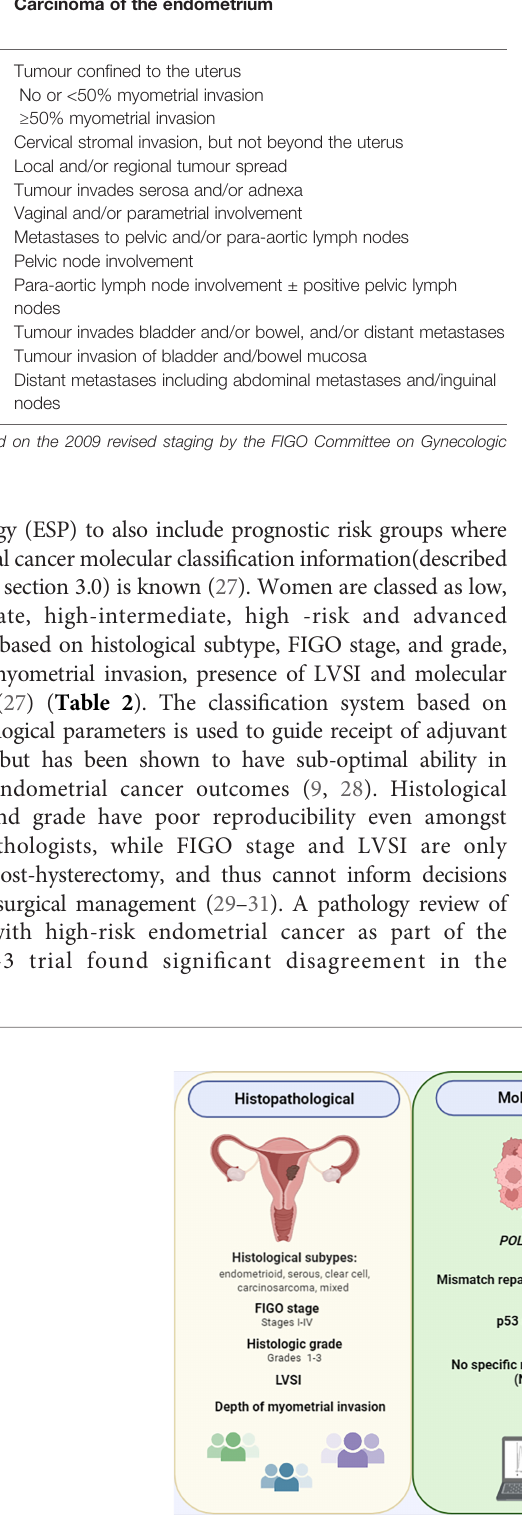
FIGURE 1 | Current and emerging endometrial cancer prognostic